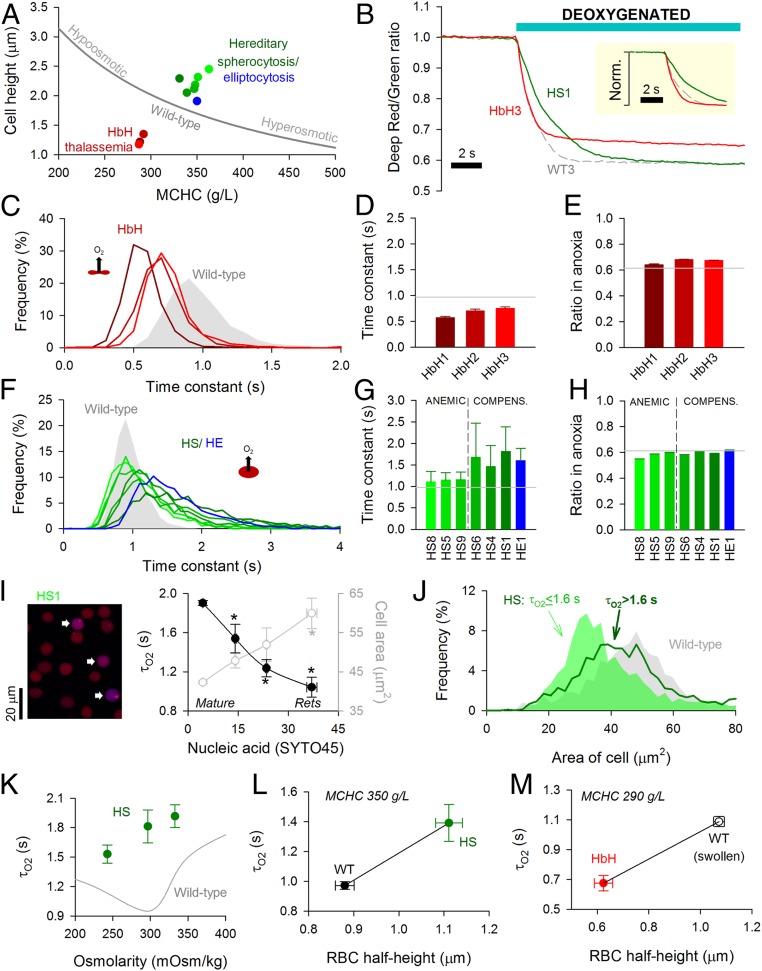
Disorders of RBC shape, size, and Hb affect O2 unloading. (A) Relationship between MCHC and cell height (thickness) for wild-type (WT) RBCs under various conditions of osmolarity (gray line) compared with data for HbH thalassemia (red), HS (green), and HE (blue). (B) Exemplar time course of O2 unloading in HbH, HS, and WT RBCs. (Inset) Traces normalized. (C) Frequency distribution of O2 unloading time constant (τO2) for HbH blood. (D) Mean ± variance for τO2 and (E) overall fluorescence ratio response in HbH RBCs (n = 968, 654, 1,152). Gray lines show mean for WT1 to WT4. (F) Frequency distribution of τO2 for HS and HE blood. (G) Mean ± variance for τO2 and (H) overall fluorescence ratio response (n = 834 to 1,811) for samples obtained from anemic and compensated HS patients and the compensated HE patient. Gray lines show mean for WT1 to WT4. (I) Blood from patient HS1. Cells were loaded with Deep-Red and Green (to measure O2 saturation) and SYTO45 (to stain nucleic acids). Overlay of Deep-Red and SYTO45 fluorescence (excited at 633 and 458 nm, respectively). Cells with high SYTO45 fluorescence and O2-sensitive Deep-Red/Green ratio are identified as reticulocytes (arrows). Measurements of τO2 and cell area (in the horizontal plane) related to SYTO45 fluorescence. Mean ± SEM (n = 1,656, 52, 23, 12). Reticulocytes (Rets) manifest the fastest O2 unloading rates. * denotes significant difference to cells with lowest SYTO45 signal (P < 0.05). (J) Distribution of cell area measured in the horizontal plane for HS RBCs from all six patients studied gated by τO2. (K) Relationship between osmolarity and τO2 for HS blood. Mean ± variance (n = 1,811, 1,267, 980). (L) Relationship between cell half-height and τO2 for WT and HS matched for comparable MCHC. (M) Relationship between cell half-height and τO2 for HbH and WT RBCs that have been hypoosmotically swollen to match the hypochromia in HbH (NaCl reduced by 25 mM).